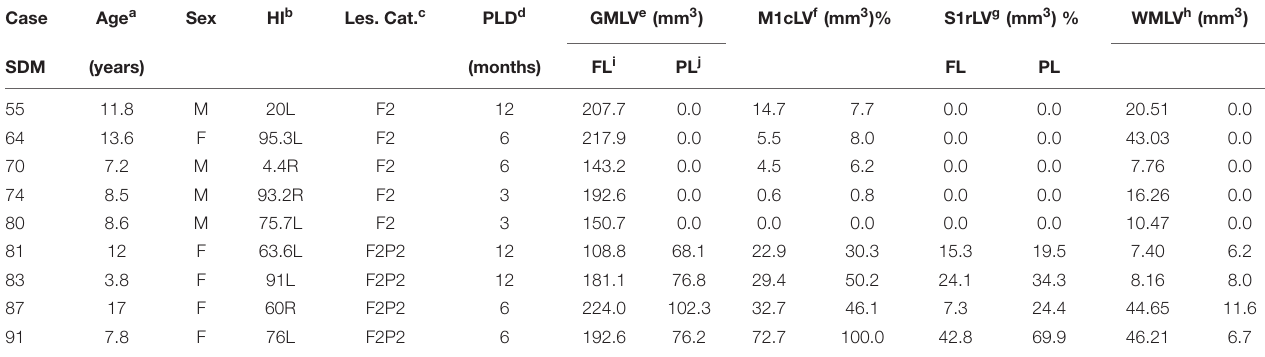
TABLE 1 | Characteristics and experimental parameters of